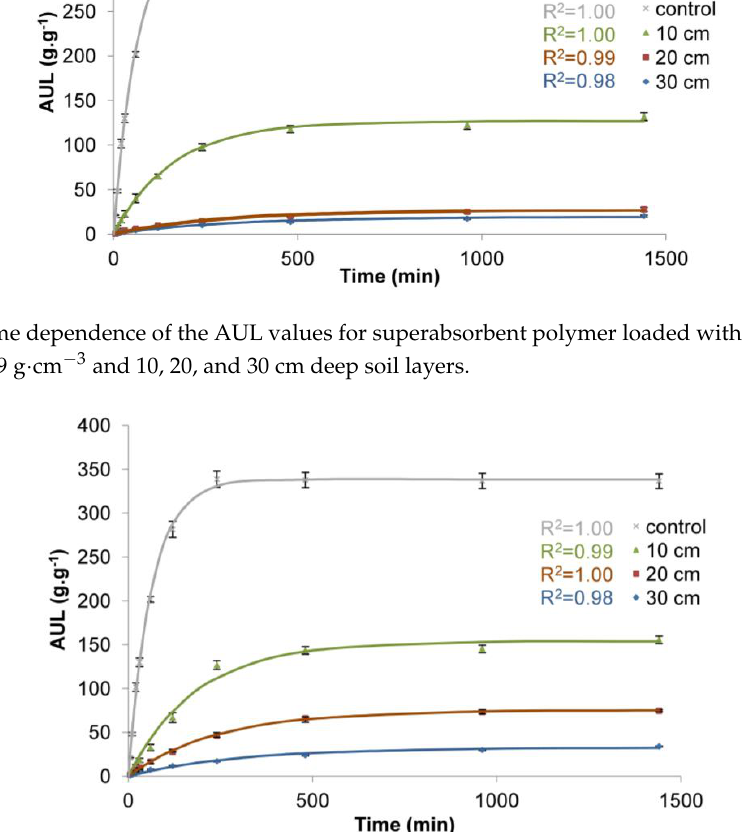
Figure 6. Time dependence of the AUL values for superabsorbent polymer loaded with soil of a bulk density of 0.5 g · cm − 3 and 10, 20, and 30 cm deep soil layers.